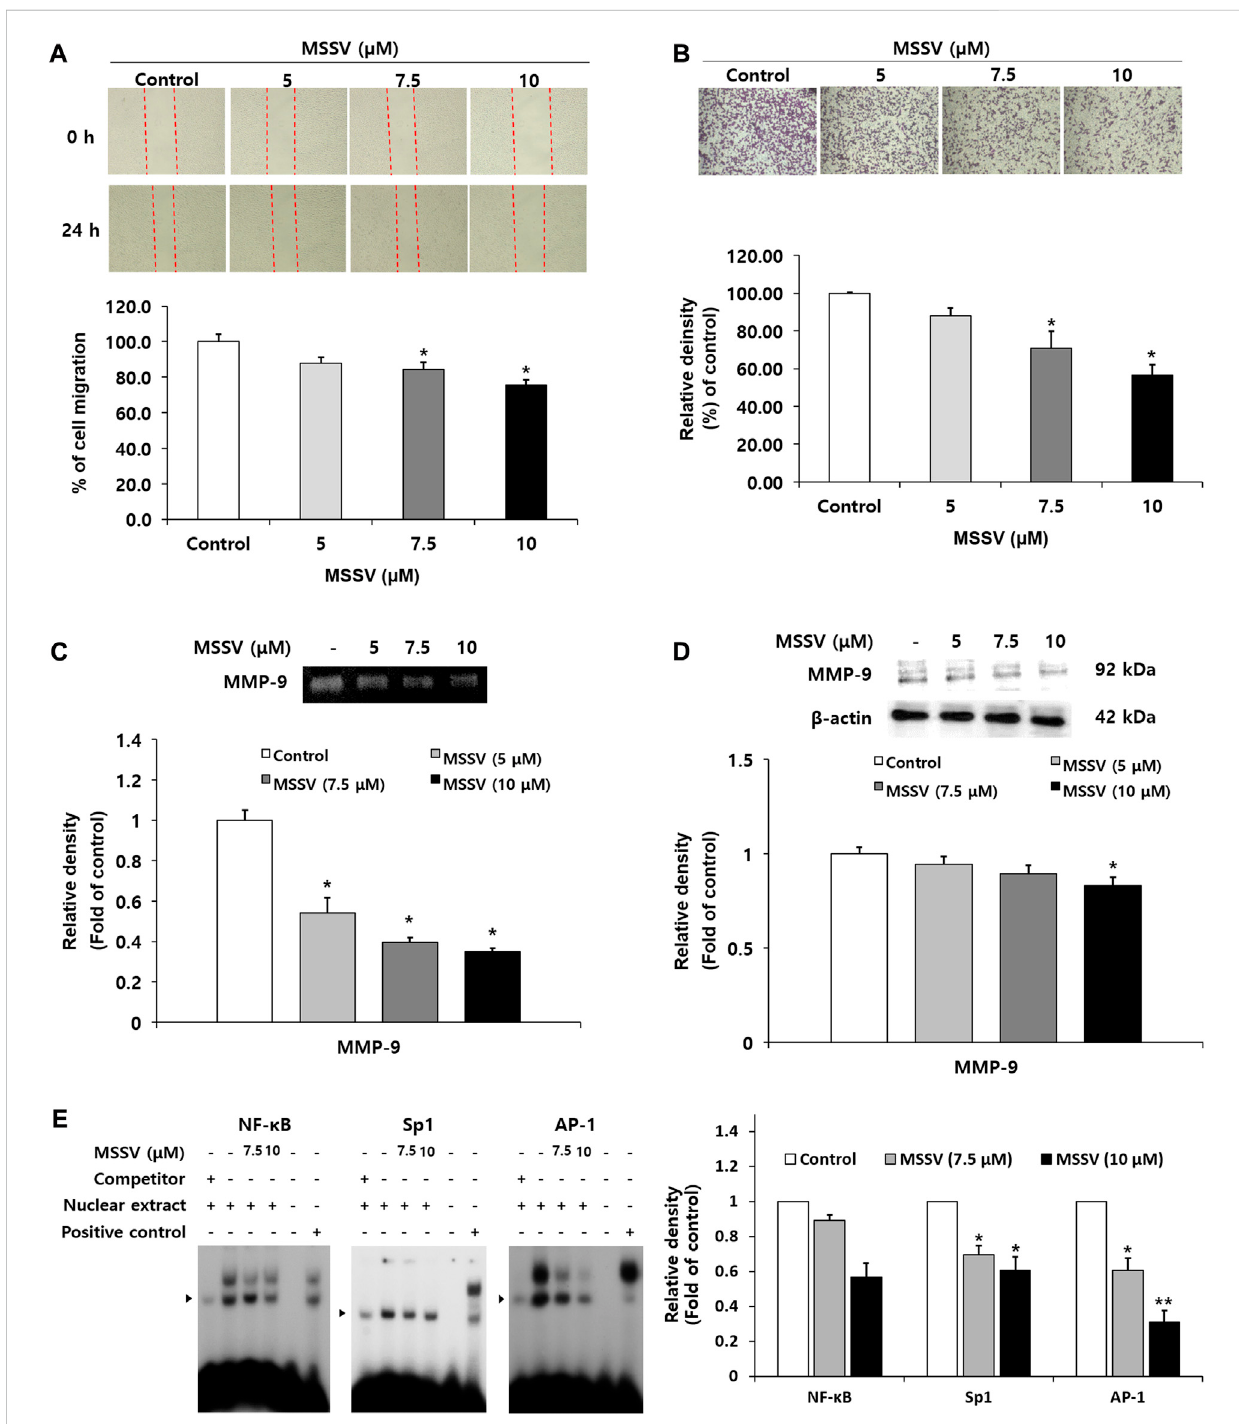
FIGURE 6 MSSV suppressed migration and invasion ability of HCT116 cells through decreased transcription factor-mediated MMP-9 expression (A) The inhibitory effect of MSSV on cell migration was determined by a wound-healing assay. Cells were plated on a 6-well plate and then incubated with MSSV (0,10,12.5,15,17.5,and20 μ M)for24 h.Thewoundclosure(%)wascalculatedasapercentageofmigration. (B) Theinvasiveabilityofcellswasestimated usingatranswellinvasionassay.CellsweretreatedwithvariousconcentrationsofMSSV(0,5,7.5,10,12.5,and15 μ M)for24 h.Therelativedensityof invading cells is represented by a bar graph. (C) Gelatin zymography analysis was performed to analyze the activity of MMP-9. The bar represents the proteolytic activity of MMP-9. (D) MSSV reduced the expression level of the MMP-9 protein in HCT116 cells. Cells were treated with MSSV at concentrationsof5,7.5,and10 μ M.TherelativedensityofMMP-9isexpressedbyabar. (E) ThebindingabilityoftranscriptionfactorsAP-1,Sp-1,andNF- κ B was veri fi ed using an EMSA experiment. The unlabeled AP-1, Sp-1, and NF- κ B oligonucleotides were used as a 50x competitor. The * (asterisk) indicates a statistically signi fi cant difference and a p -value of < 0.05 was considered statistically signi fi